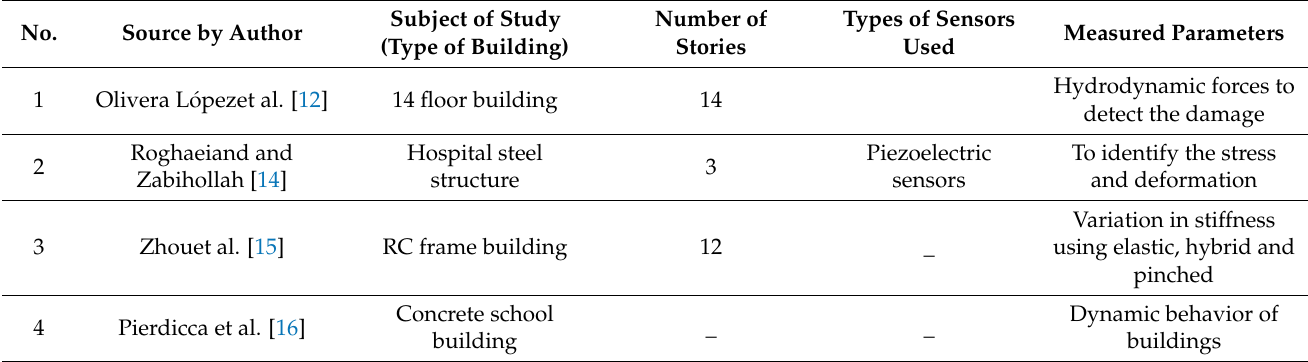
Table A1. List of the reviewed buildings with the implemented